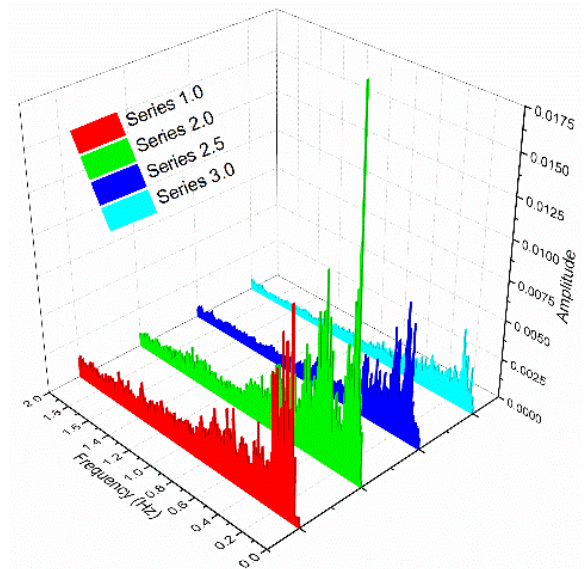
Figure 16. Marginal spectrum.